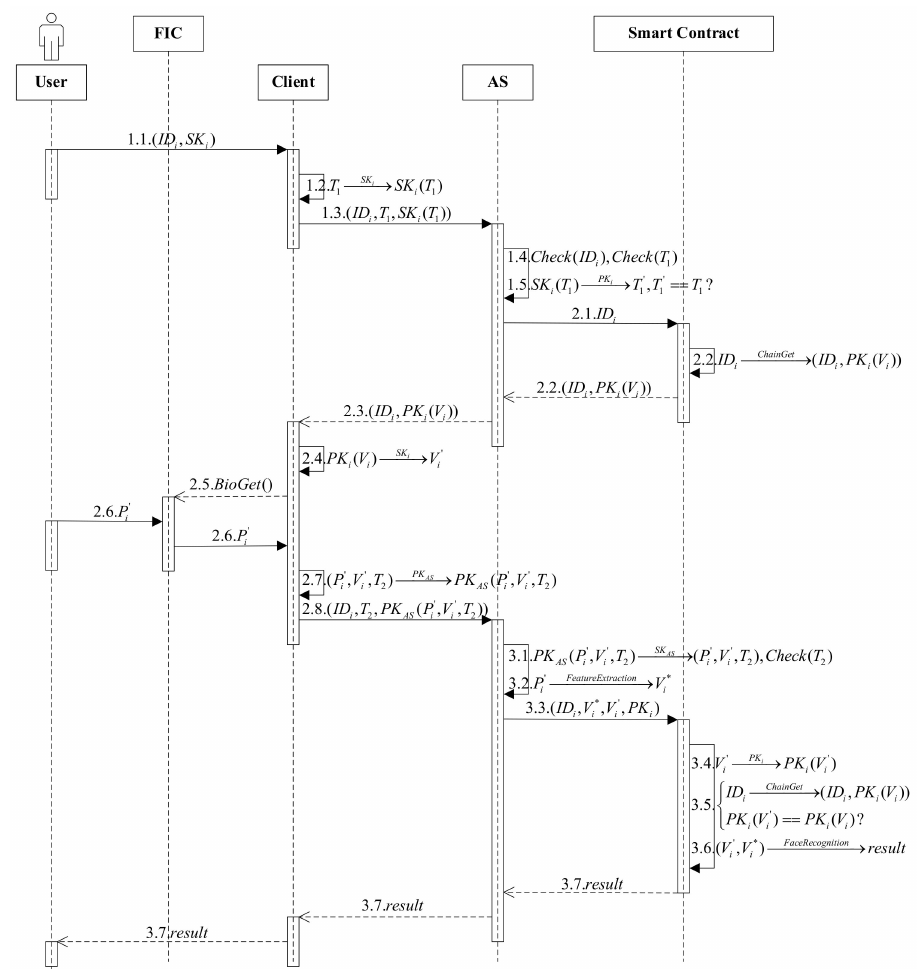
Figure 6. Local domain authentication process. The user sends the login information and face information to the AS node through the client. The AS reads the registration information stored on the consortium chain according to the login information, compares the login information with the registration information, and returns the registration